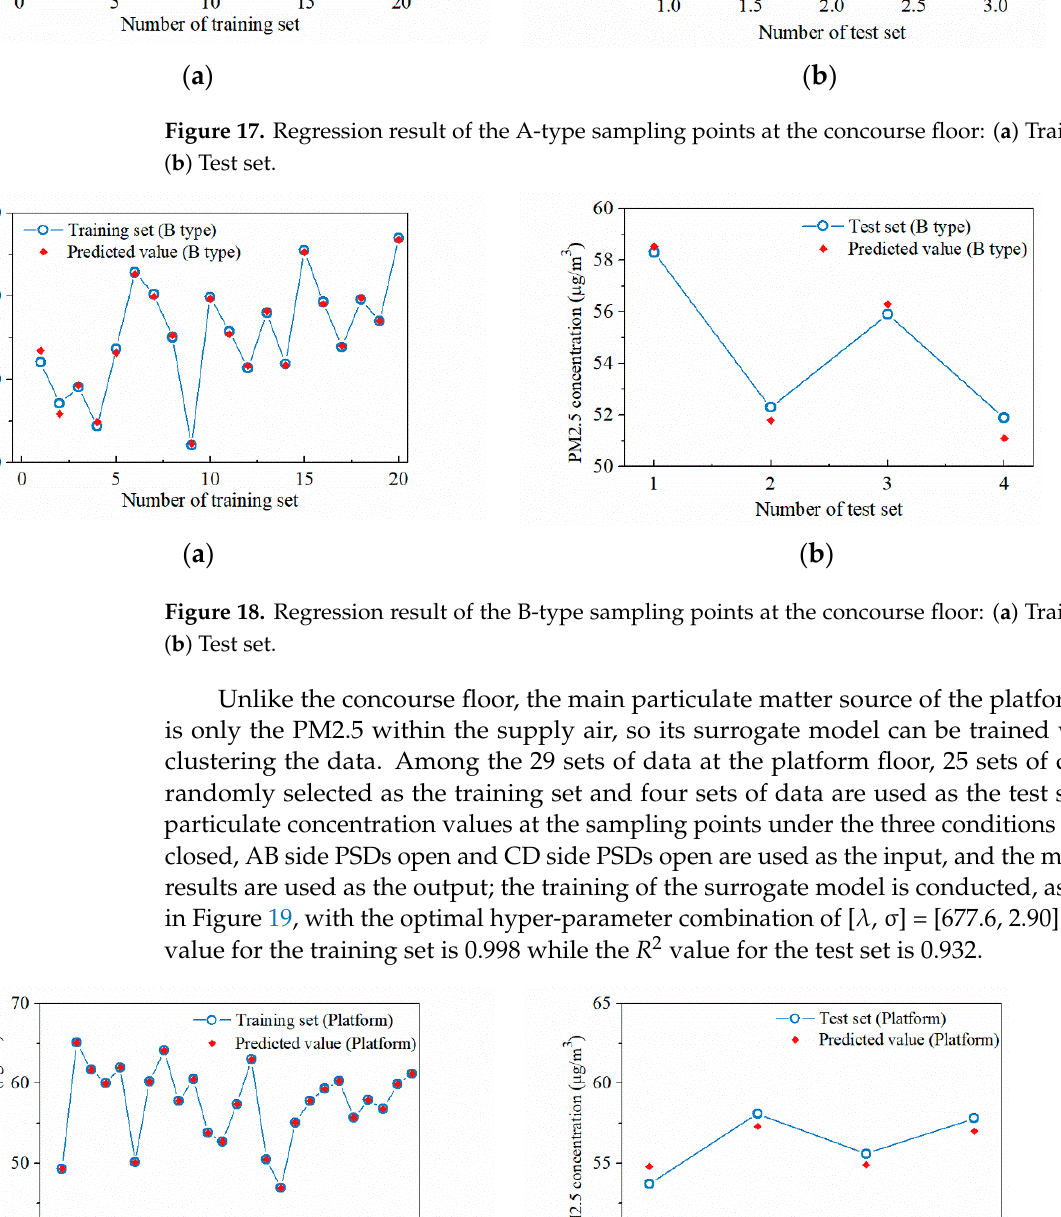
Figure 19. Regression result of the sampling points at the platform floor: ( a ) Training set; ( b ) Test set.